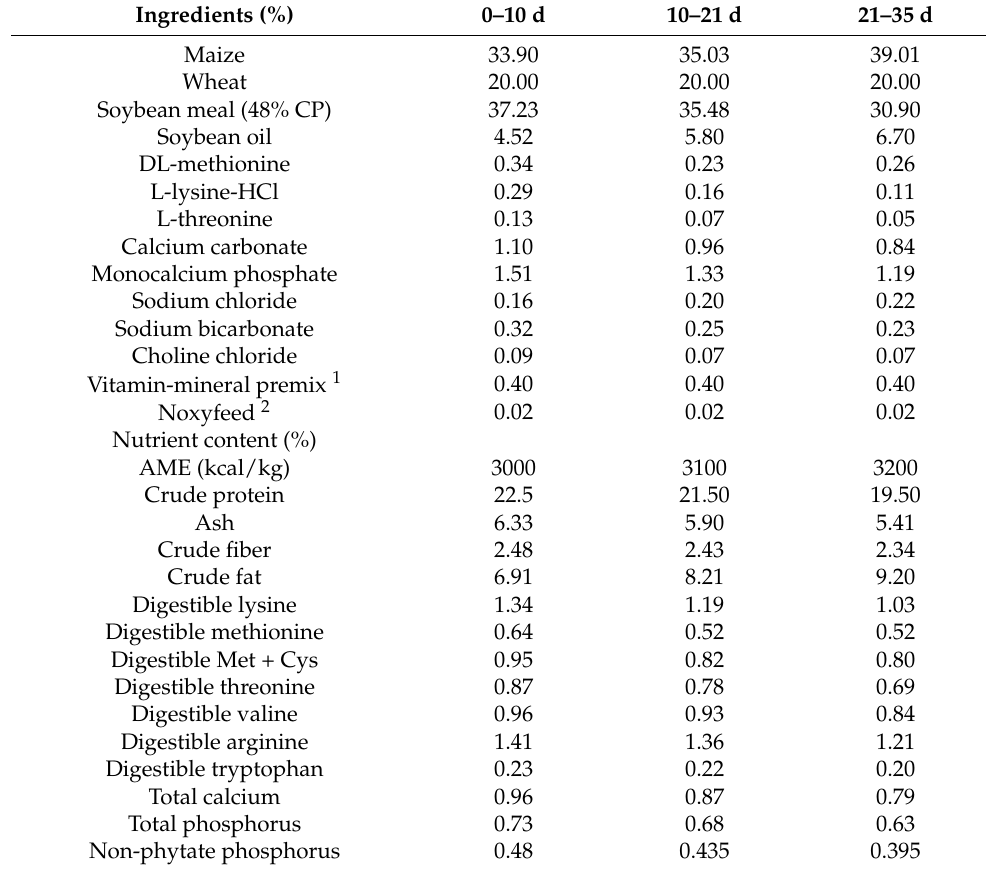
Table 1. Formulation and proximate analysis of experimental basal